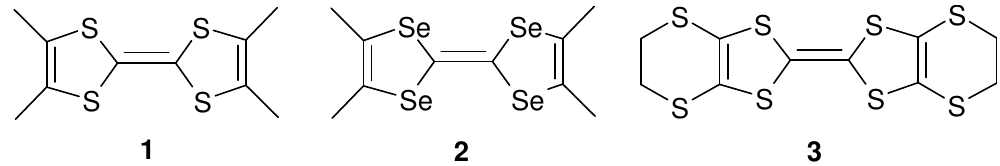
Figure 1. Molecular structures of tetra-methyl-tetra-thia-fulvalene (TMTTF),